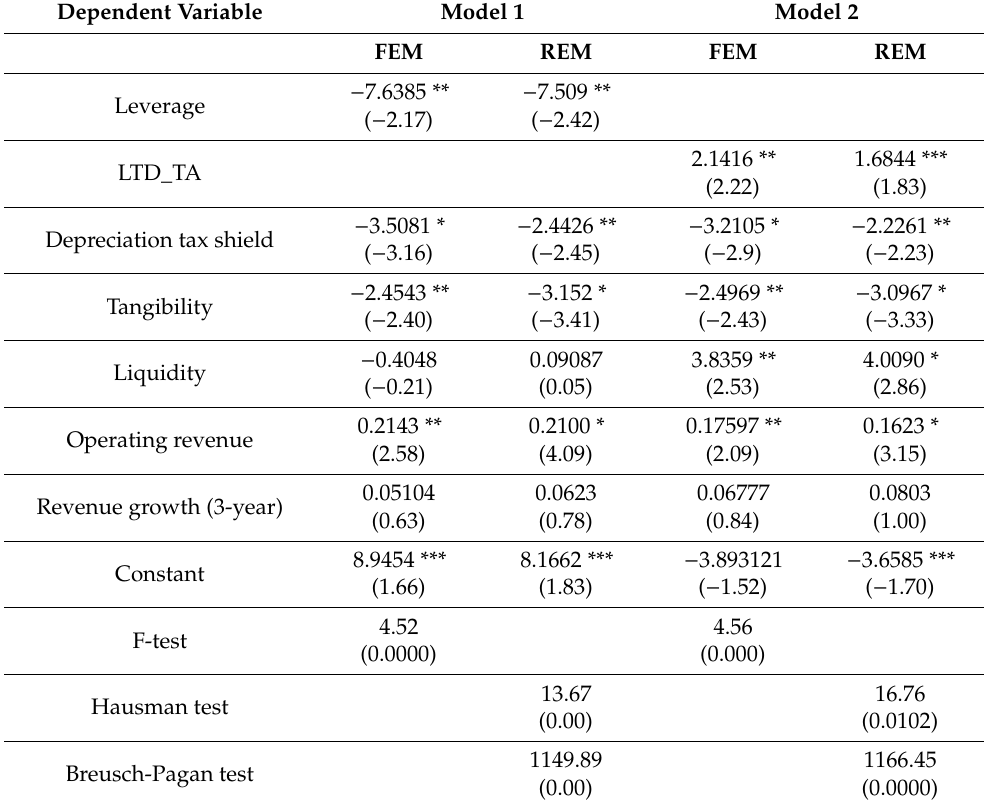
Table 6. Return on invested capital